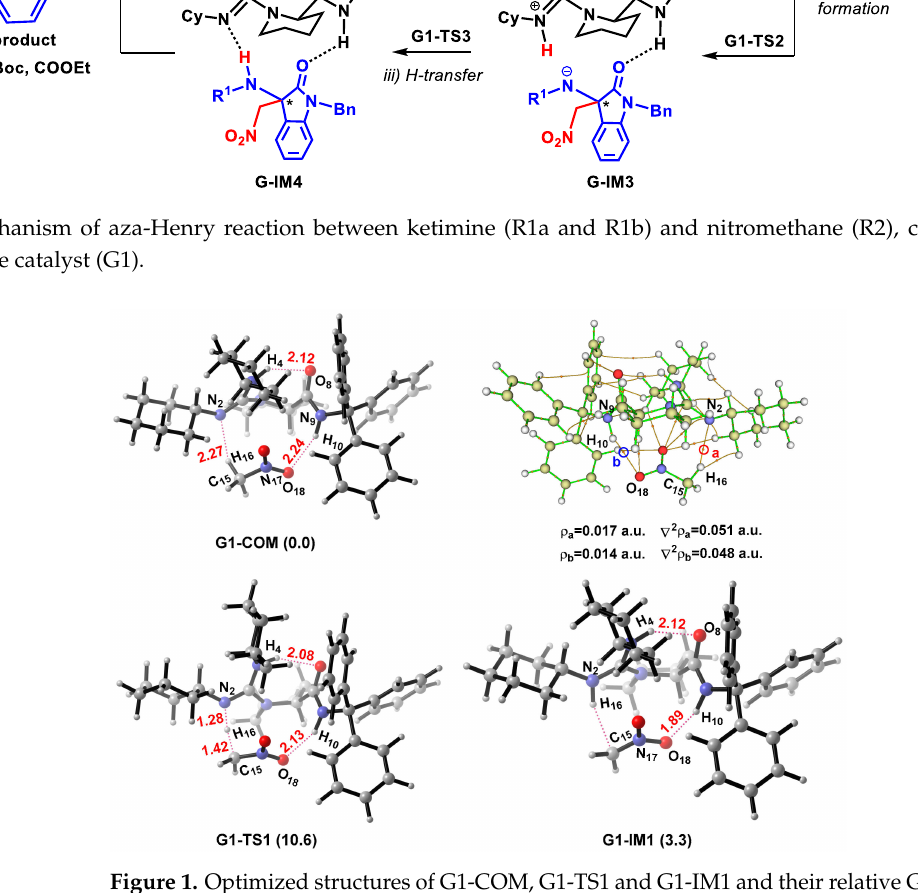
Figure 1. Optimized structures of G1-COM, G1-TS1 and G1-IM1 and their relative Gibbs free energies (in kcal · mol − 1 ). The distances are in Å. Laplacian ( ∇ 2 ρ ) and electronic density ( ρ ) values of the selected bond critical points (BCP) in G1-COM were obtained by atom in molecule (AIM)